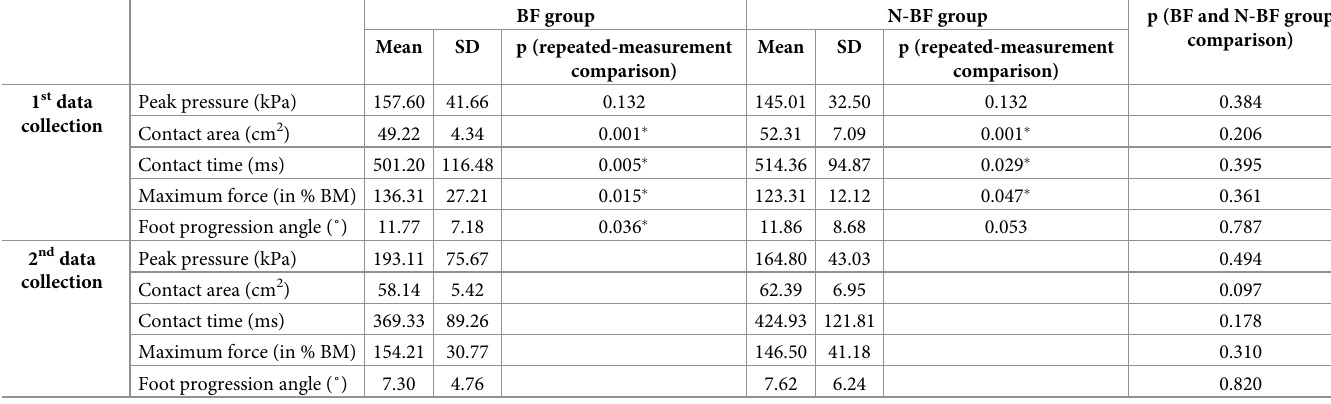
Table 4. Results of analysed gait parameters in the total foot.